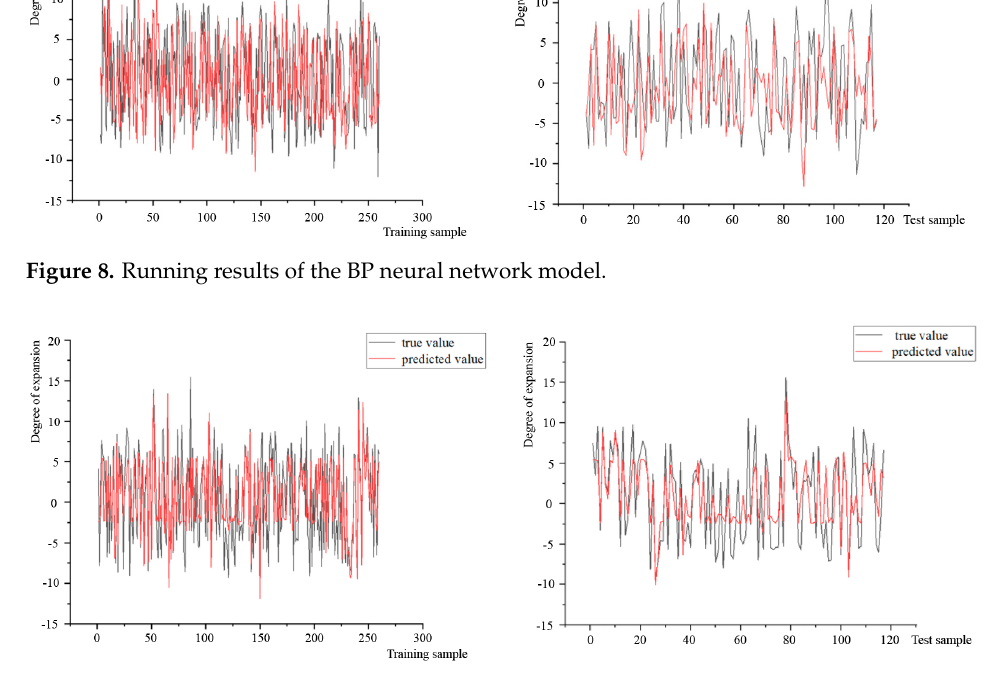
Figure 9. Running results of the BAS-BP neural network model.